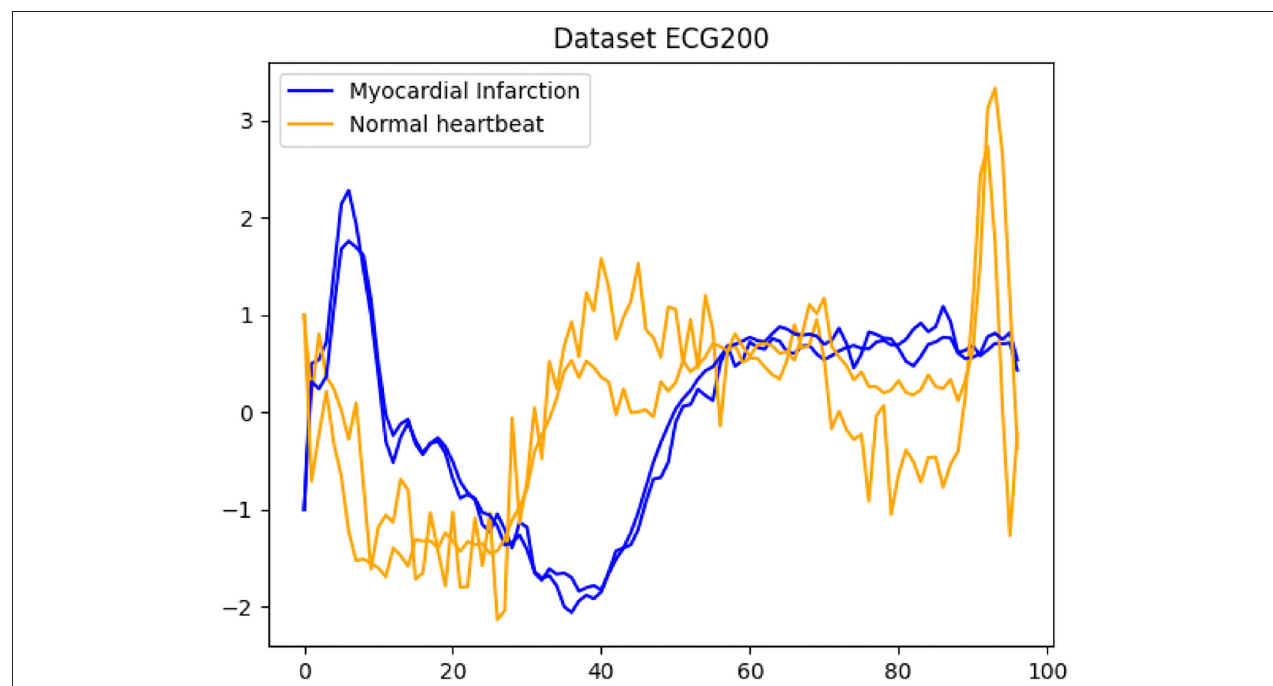
FIGURE 1 | A typical example for time series classification. Given the dataset ECG200, the goal is to automatically separate all time series into the classes normal heartbeats and myocardial infarction .